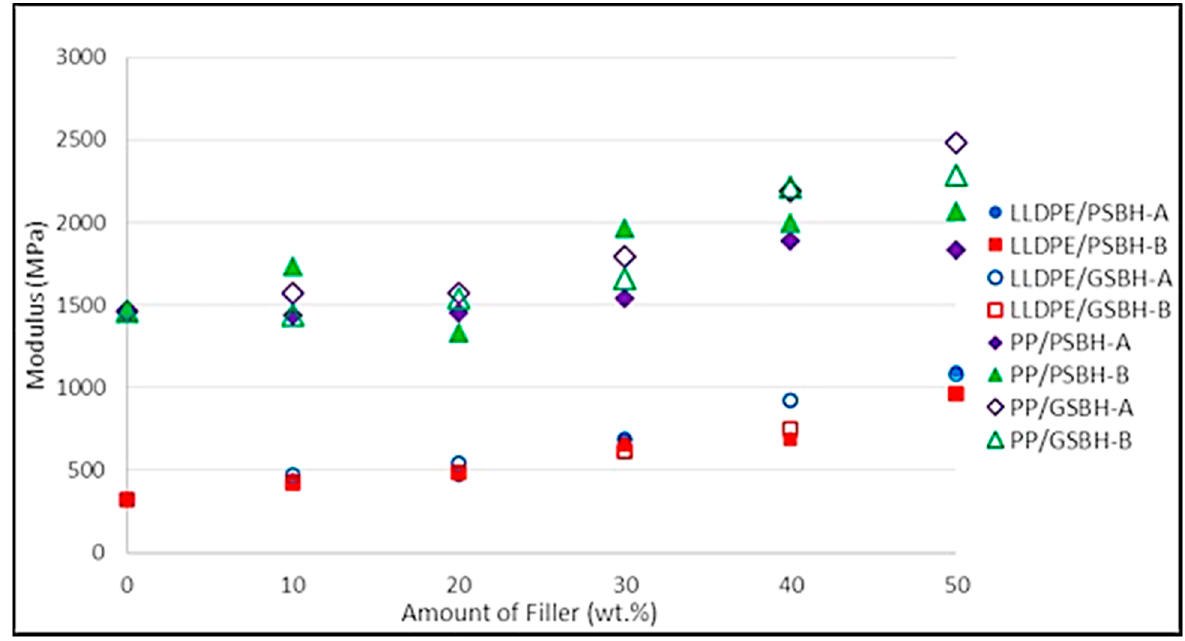
Figure 8. Modulus of elasticity of all composites at all weight percentages.